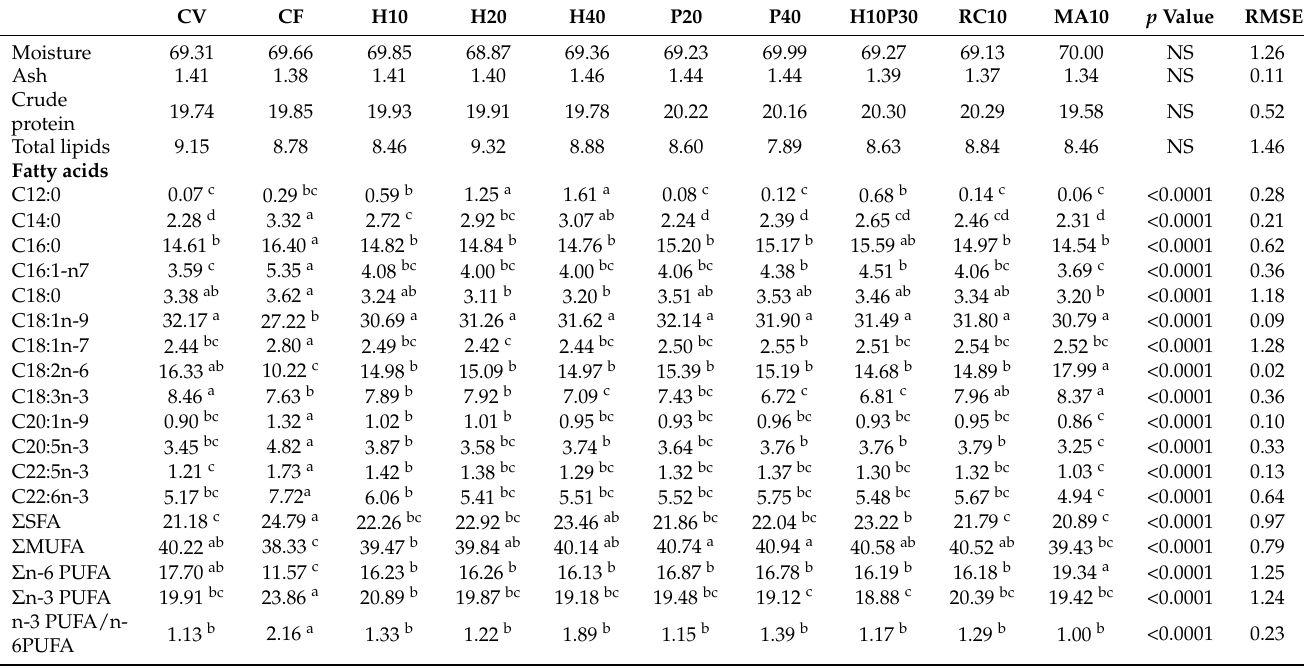
Table 5. Chemical composition (g 100 g − 1 fresh tissue) and fatty acids profile (g 100 g − 1 total FAME) of the fillets from gilthead sea bream ( Sparus aurata ) fed the experimental diets.